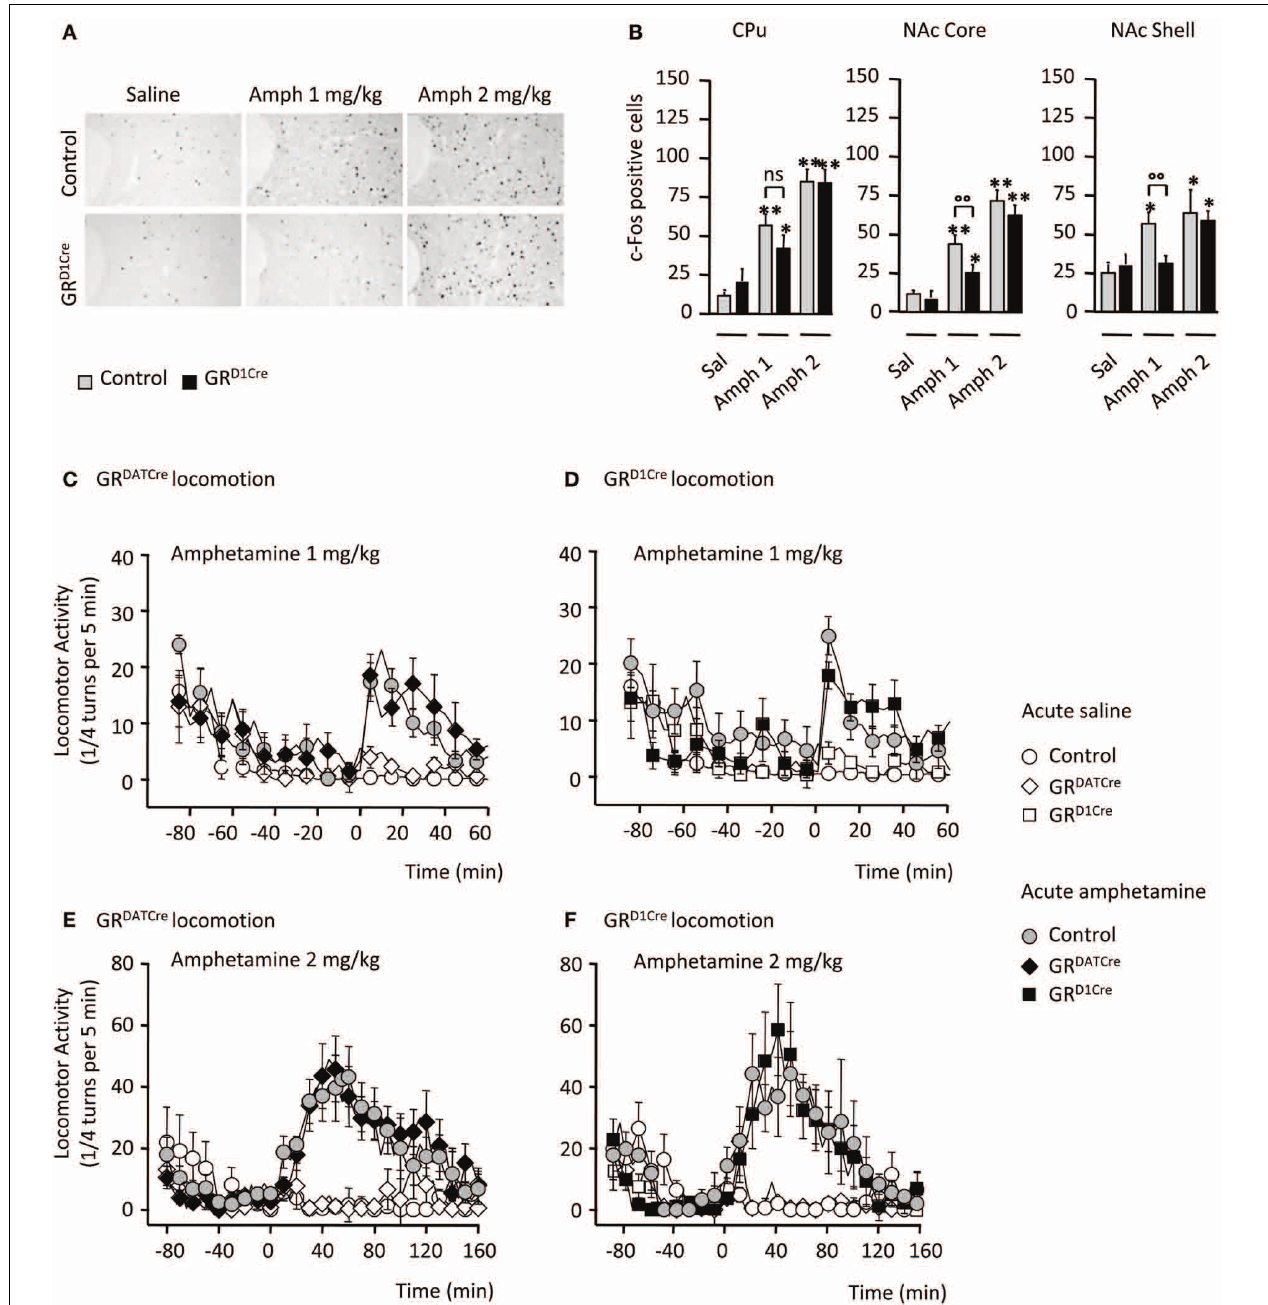
FIGURE 1 | Impaired molecular but not locomotor responses following an acute amphetamine challenge in GR D1Cre mice. (A) Representative example of c-Fos induction in the NAc core of a control and a GR D1Cre mouse in response to saline, amphetamine 1 and 2mg/kg. (B) Amphetamine-induced c-Fos expression in the caudate-putamen (left panel), the nucleus accumbens core (middle panel), and shell (right panel) of control and GR D1Cre mice. n = 4–8 animals per group; saline vs. drug: ∗ P < 0 . 05; ∗∗ P < 0 . 01; control vs. mutant: ◦◦ P < 0 . 01. Locomotor activity is expressed as the sum of ¼ turns in a circular cylinder per 5min following acute drug (gray or black) or saline (white) injections in control (circles), GR DATCre